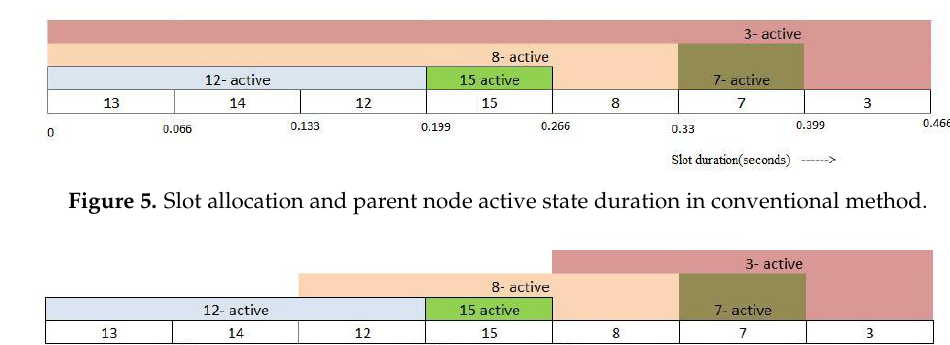
Figure 4. Example of a tree network.